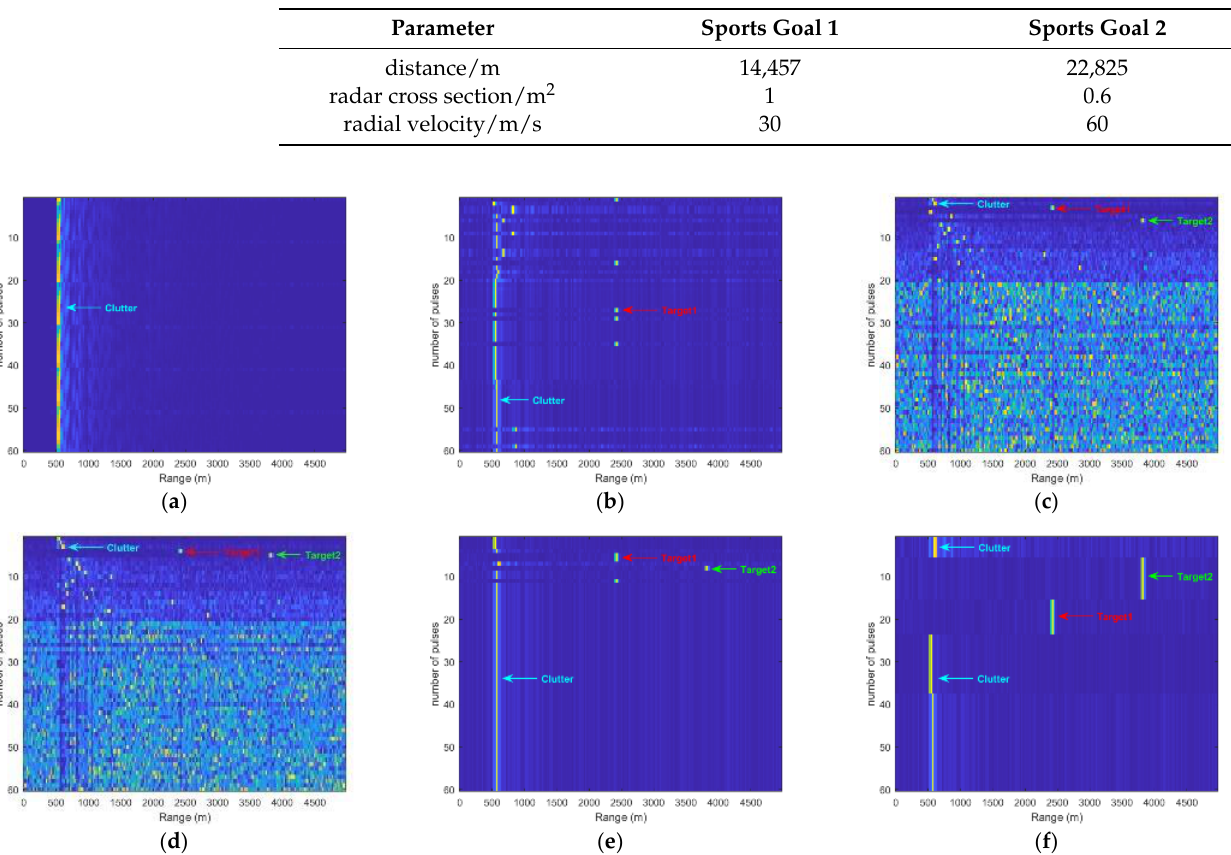
Table 12. Movement target parameters.